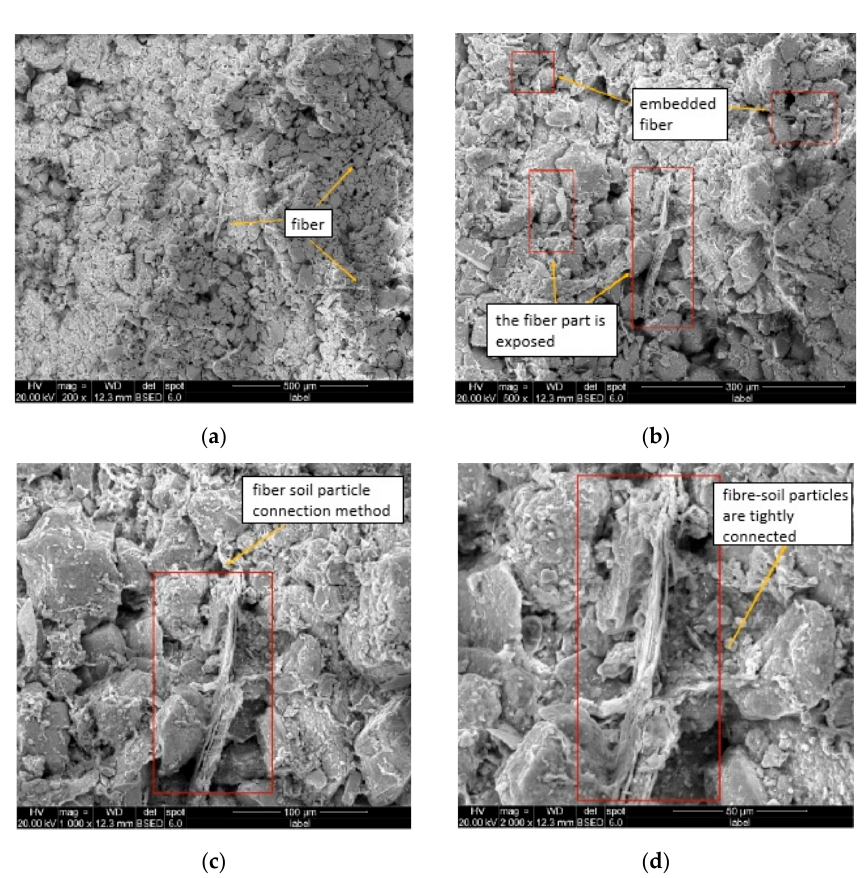
Figure 9. D-3 microscopic image of soil sample: ( a ) 200 times; ( b ) 500 times; ( c ) 1000 times; ( d ) 2000 times.